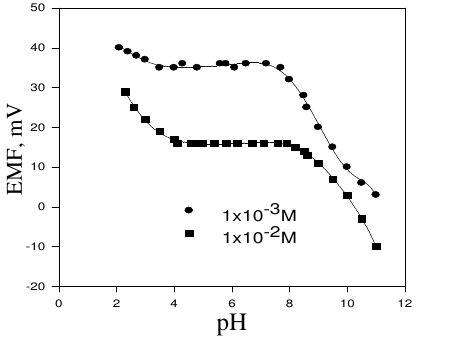
Figure 4. Effect of partially non-aqueous media on the response of Ce(III)-selective electrode based on